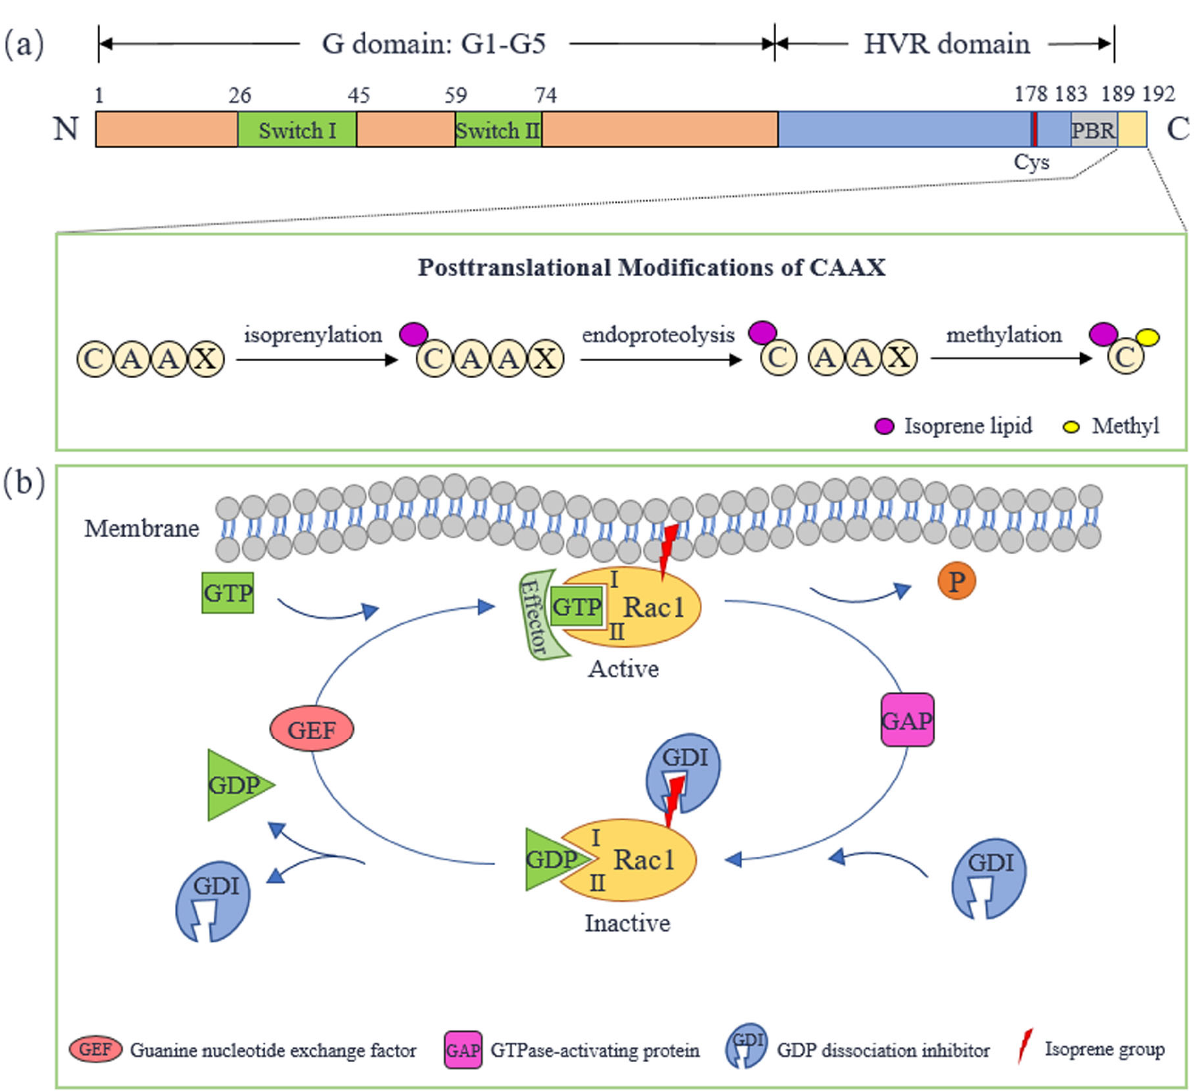
Figure 1. Molecular structure and activity regulation of Rac1. ( a ) The molecular structure of Rac1. ( b ) The cycle of Rac1 between active and inactive forms. Cys: cysteine; GEF: guanine nucleotide exchange-factor; GAP: GTPase-activating protein; GDI: GDP dissociation inhibitor; HVR: hypervariable region; PBR: polybasic region.